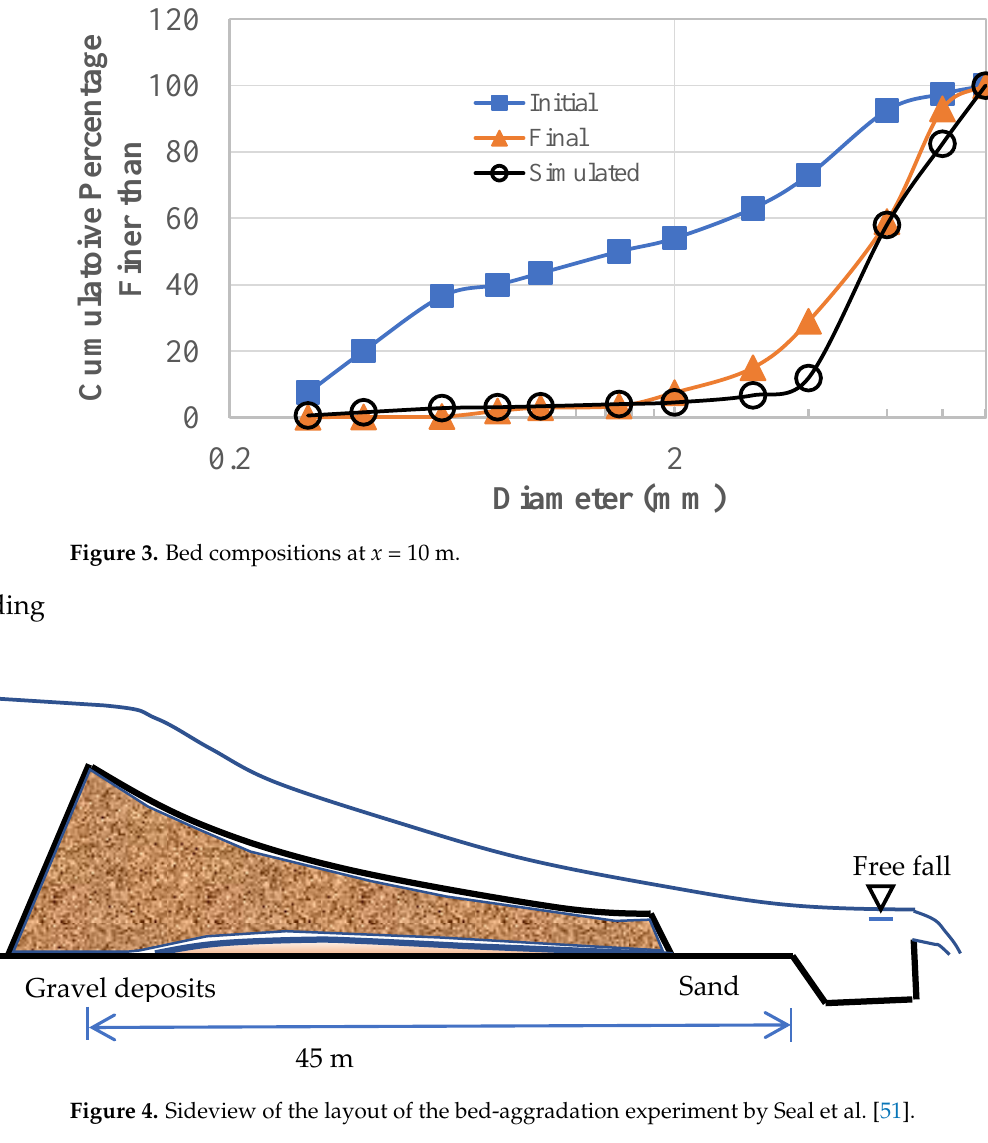
Figure 2. Erosion development profiles with time.